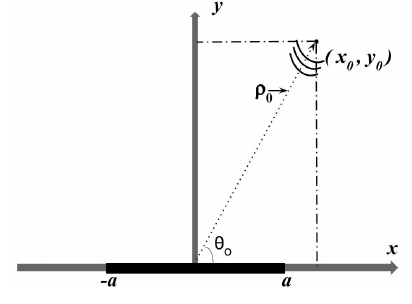
Figure 1: The geometry of the